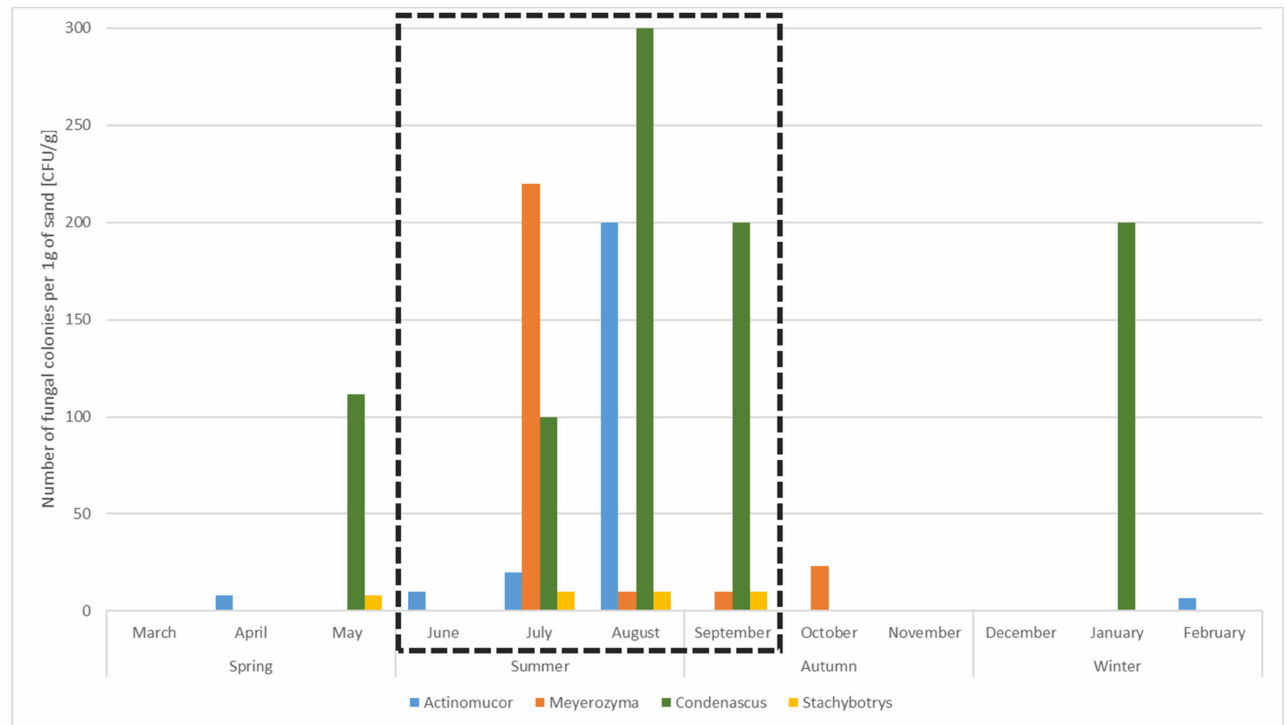
Figure 5. Presence and numbers of “potential human pollution indicator-genera” in sand samples during the period of 12 months. The official bathing season is indicated with a black, dashed